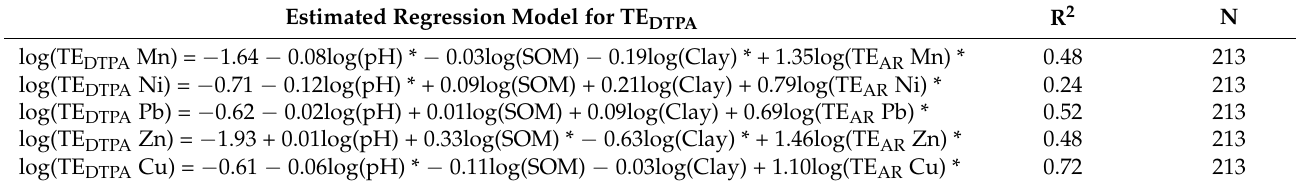
Table 3. Prediction model 1.